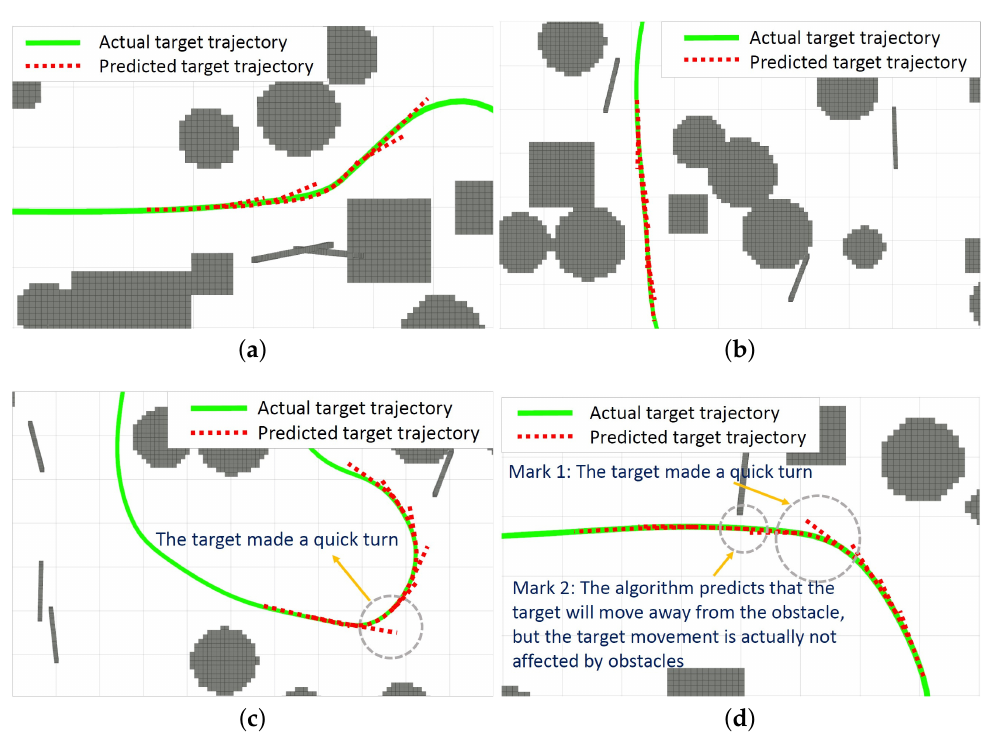
Figure 7. Performance of the proposed prediction algorithm in a variety of scenarios. ( a ) Performance of the proposed prediction algorithm in complex environment I. ( b ) Performance of the proposed prediction algorithm in complex environment II. ( c ) Performance of the proposed prediction algorithm in open environment I. ( d ) Performance of the proposed prediction algorithm in open environment